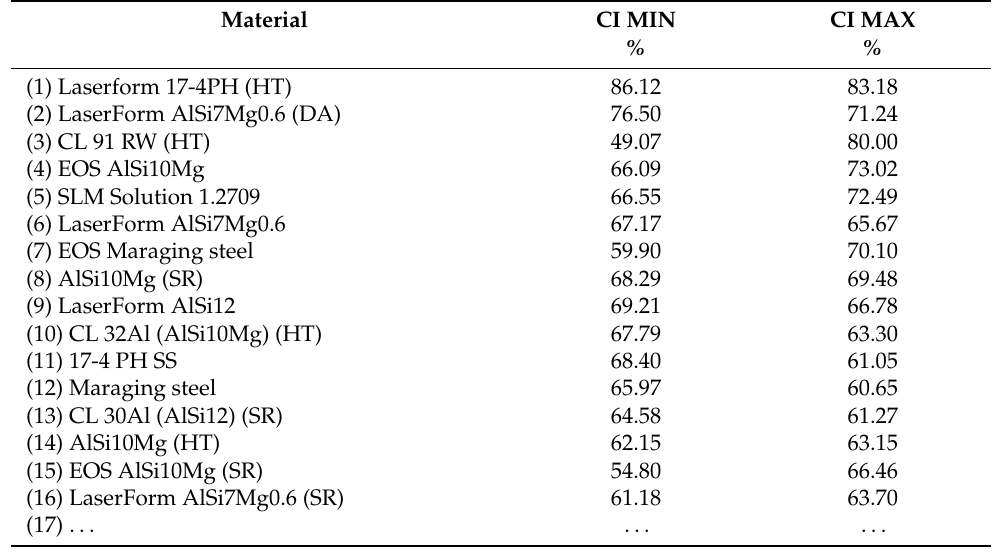
Table 11. Sorted list of materials based on Compliance Index CI (HT = heat treated; SR = stress relief; DA = direct aging).